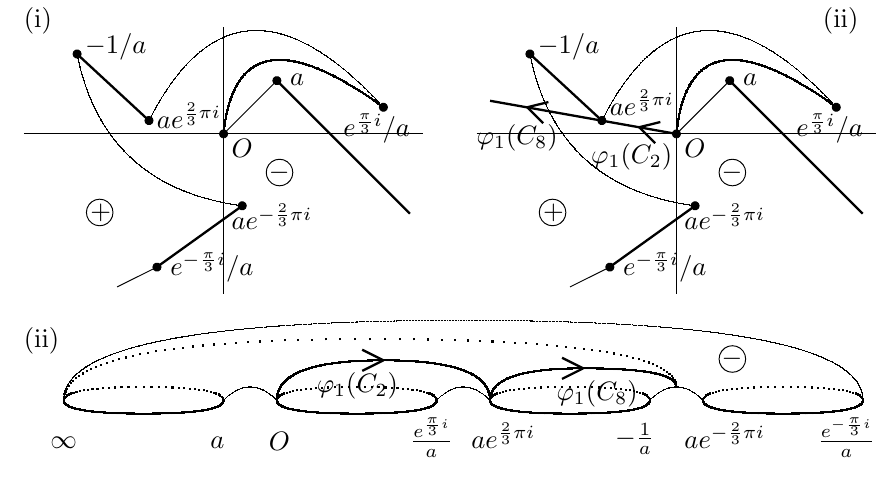
Figure A17. ϕ 1 ( C 2 ) , ϕ 1 ( C 8 ) in